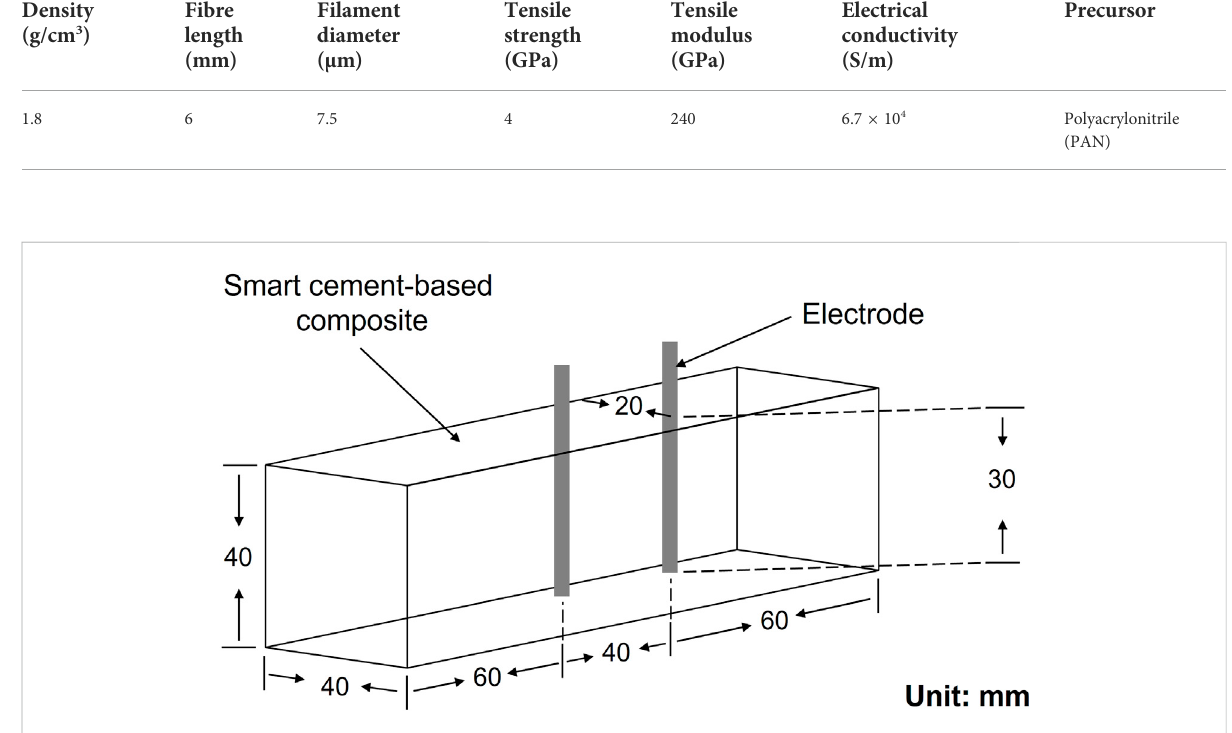
FIGURE 1 Dimension of smart cement-based composite and electrode